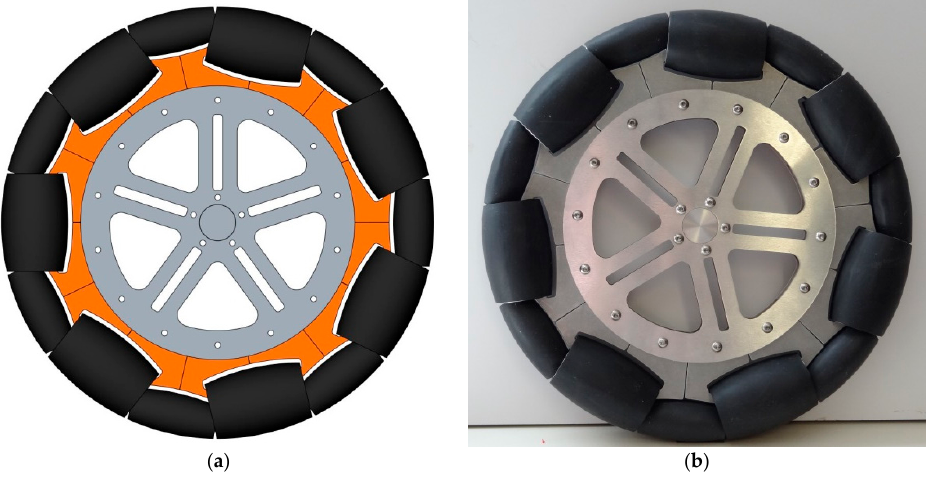
Figure 5. Design of the omnidirectional wheel: ( a ) CAD model ( b ) prototype implementation.